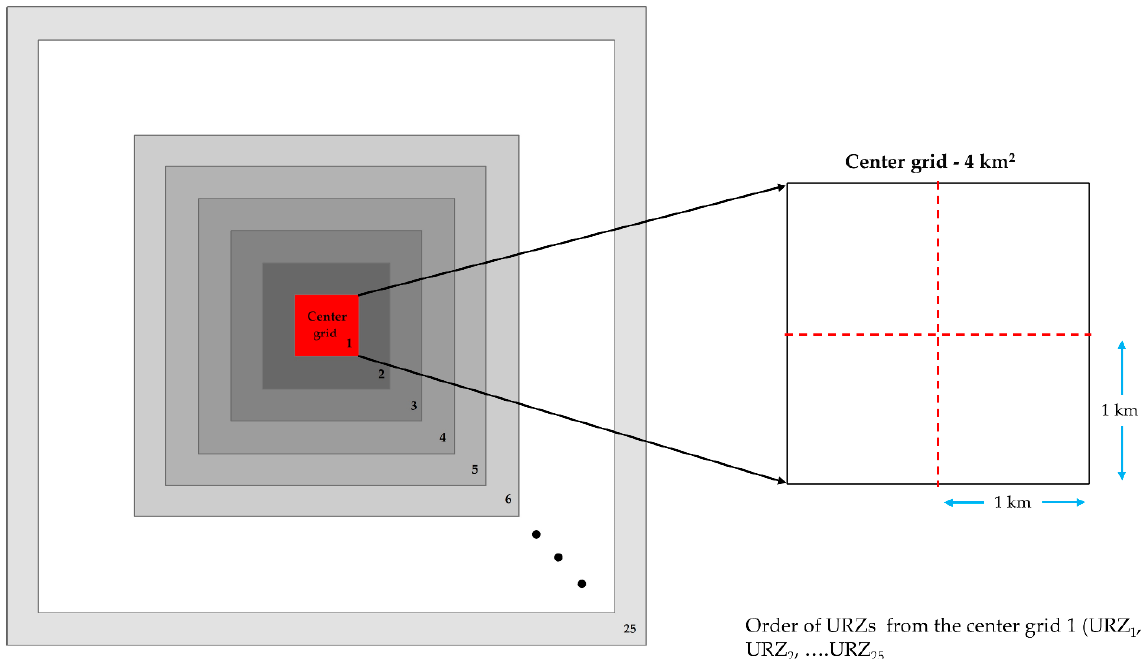
Figure A1. Graphical illustration of the URZs used to estimate daytime/nighttime surface UHI intensity along the urban–rural gradient.